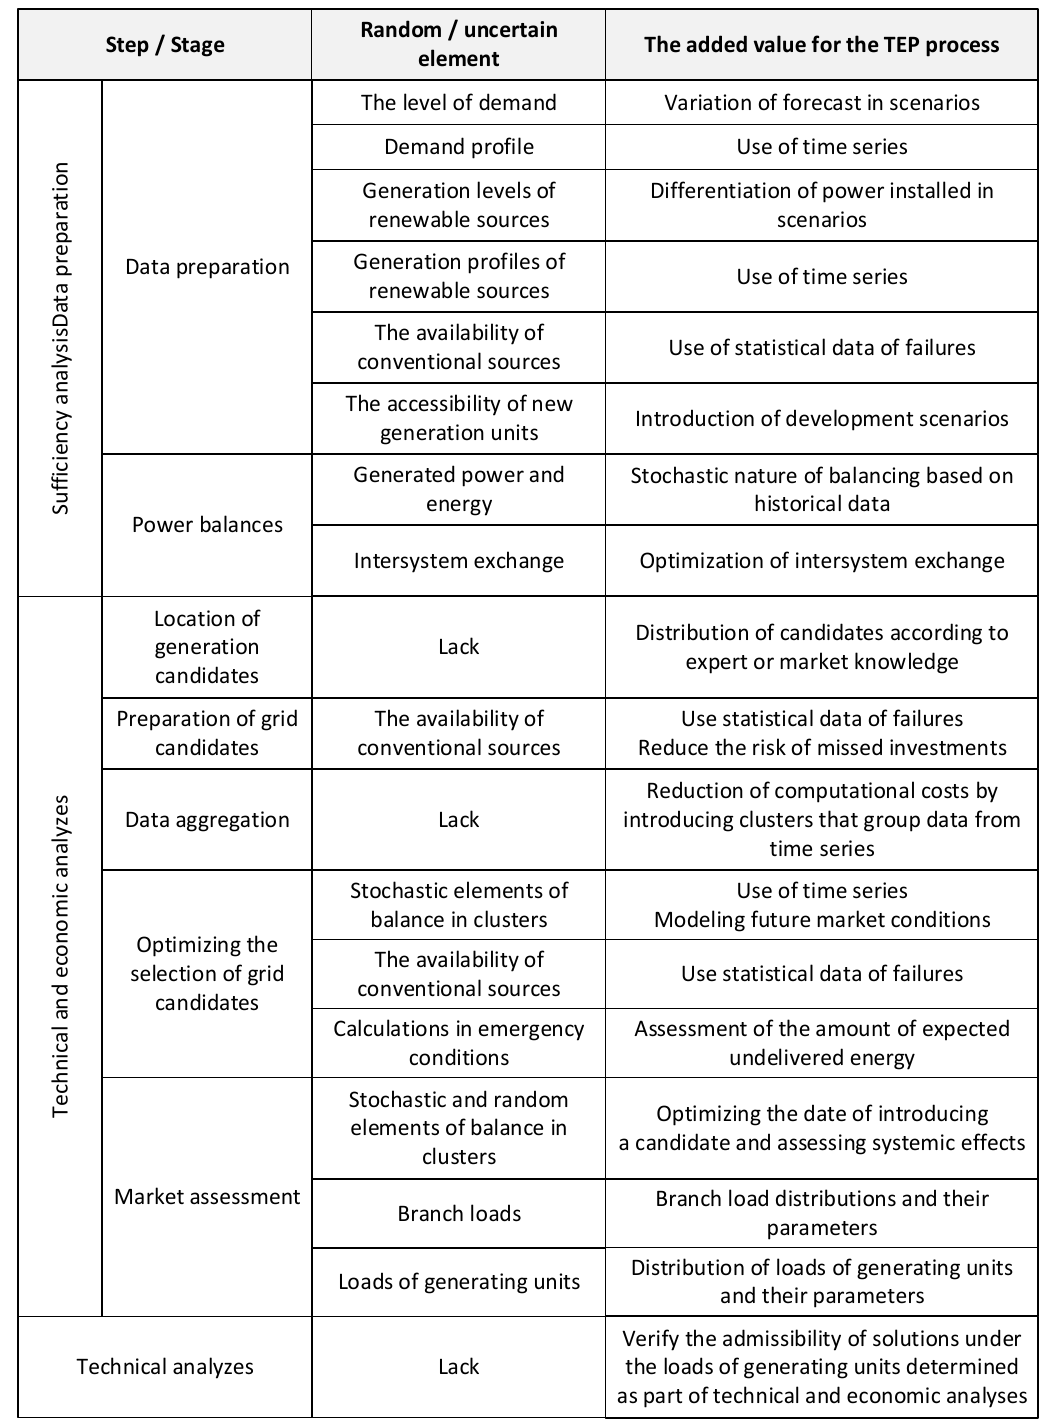
Figure 4. Elements added to the TEP process, taking into account the probabilistic approach.